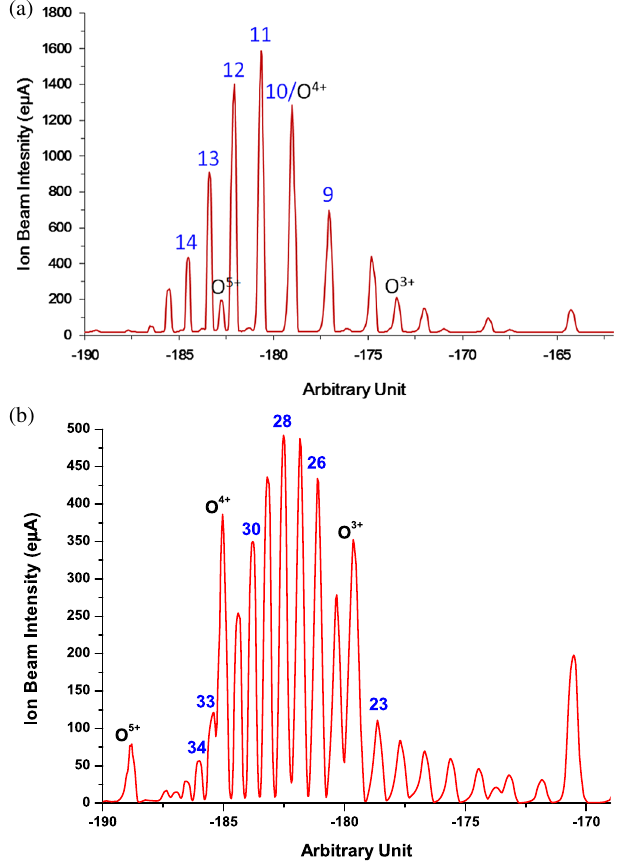
FIG. 18. CSD spectra at total microwave power 8.5 – 8.7 kW of 24 þ 18 GHz double frequency heating with the ∅ 20 mm TE circular waveguide. (a) The SECRAL source optimized for 40 Ar 12 þ . (b) The SECRAL source optimized for 129 Xe 30 þ